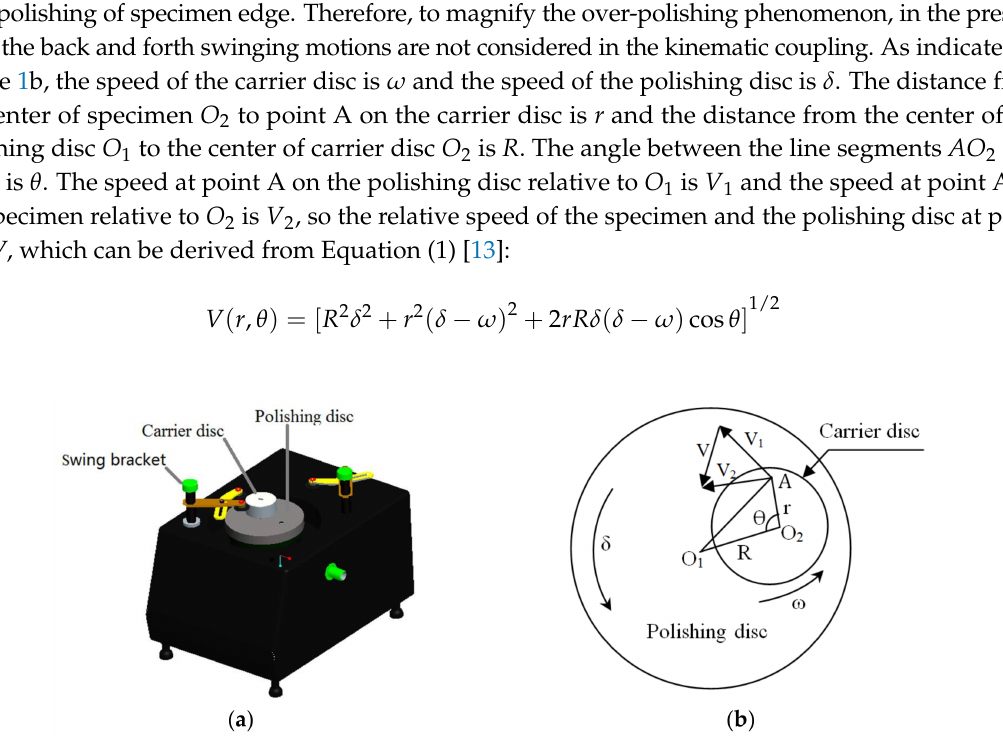
Figure 1. Illustration of annular polishing. ( a ) Model of annular polisher; ( b ) motion analysis of annular